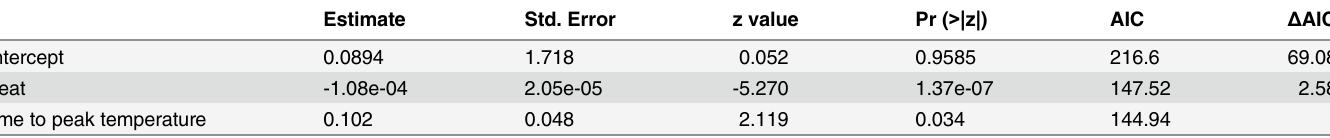
Table 7. Output summary of the logistic regression model of survival of E . atala pupae as a function of heat and time to reach peak temperature following laboratory water bath experiment, February, 2012.